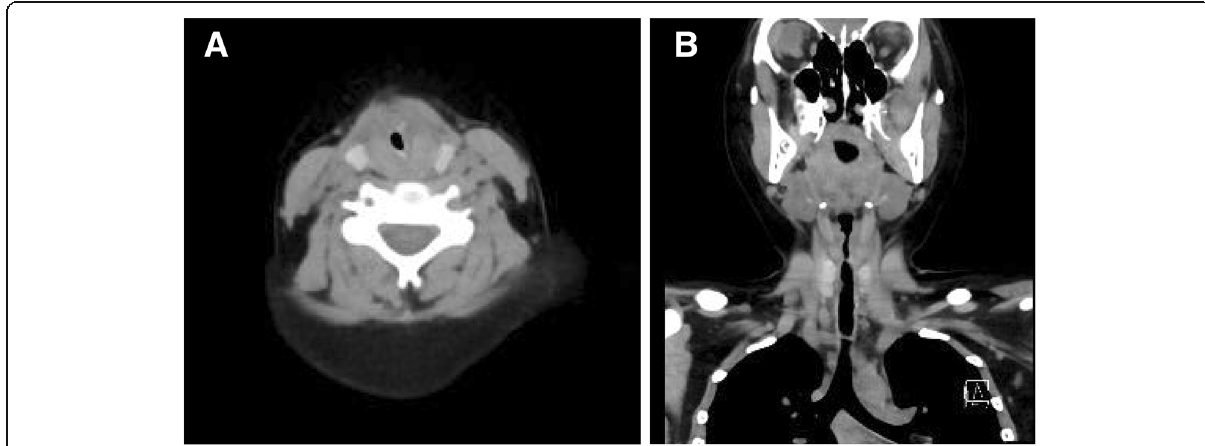
Fig. 1 CT images of the neck with severe subglottic stenosis on admission